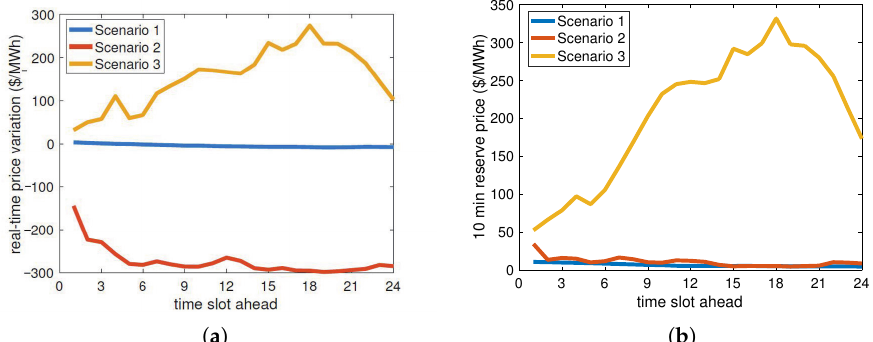
Figure 2. An example of scenario clustering for real-time price changes and reserve prices. ( a ) Real-time price change scenarios. ( b ) Reserve price